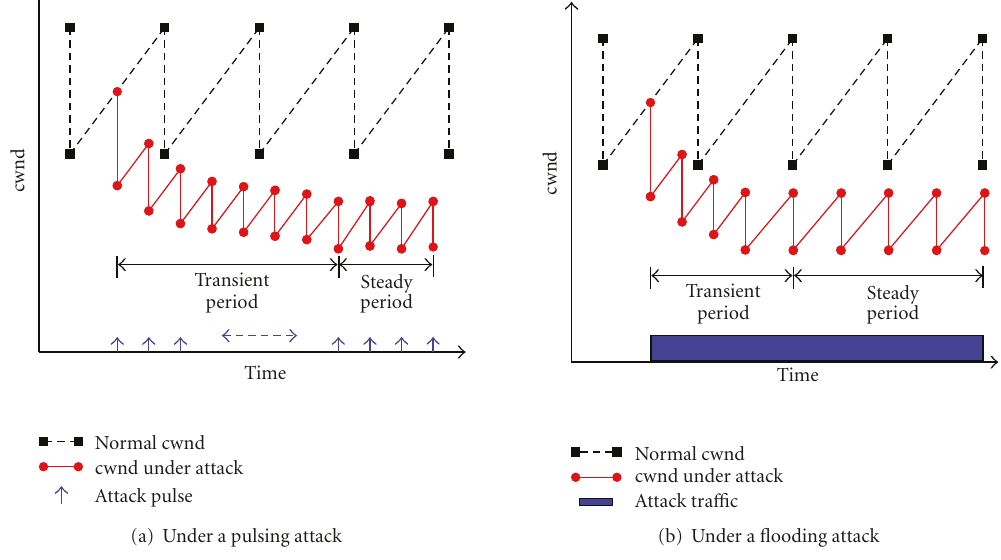
Figure 1: The evolution of cwnd under a PMDoS attack